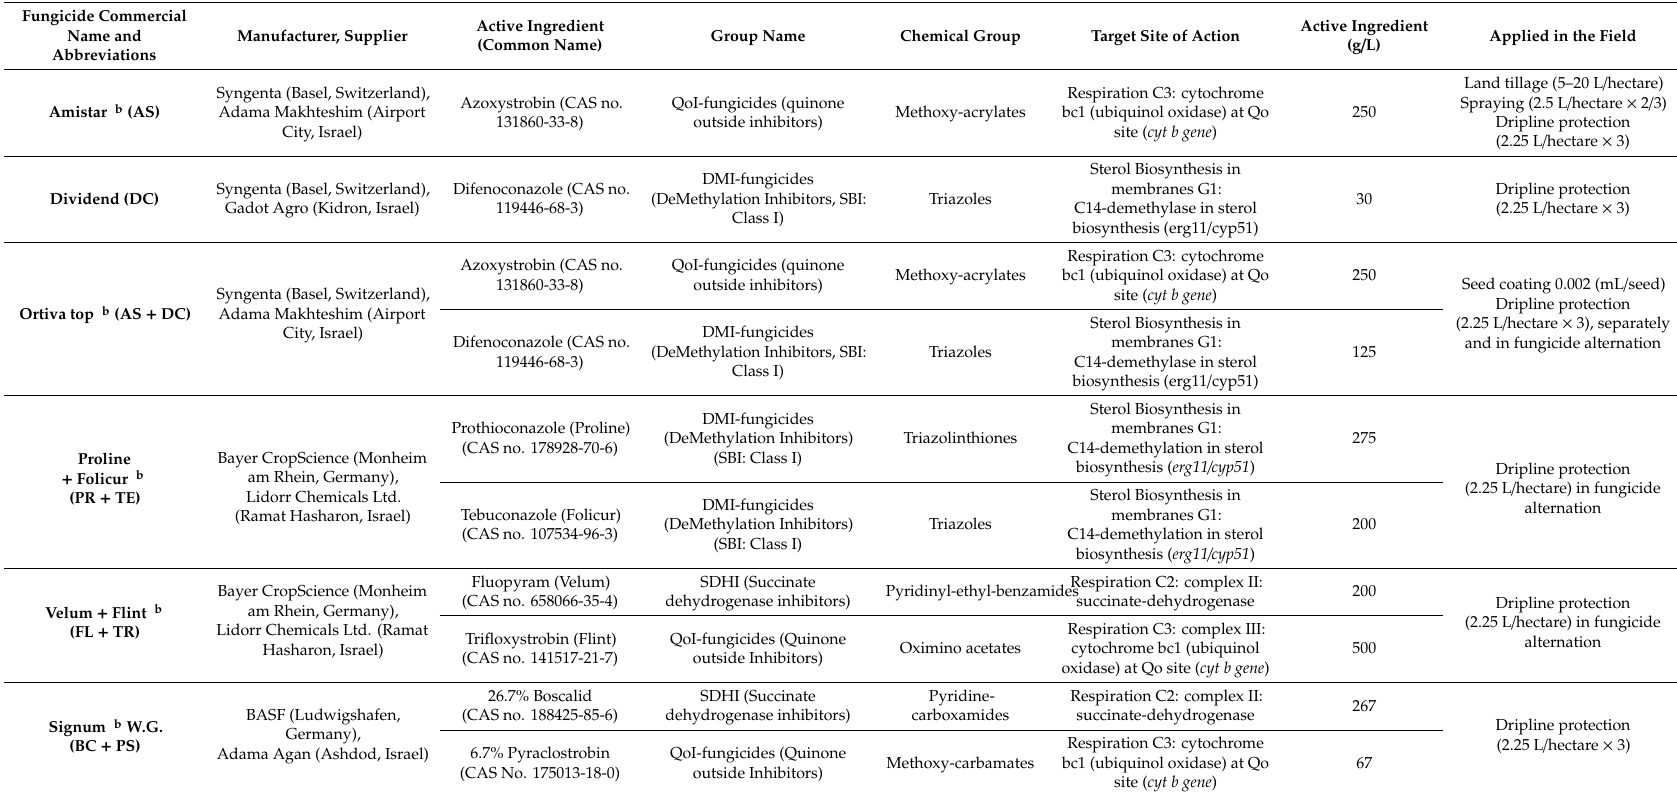
Table 3. Fungicides used in this study a